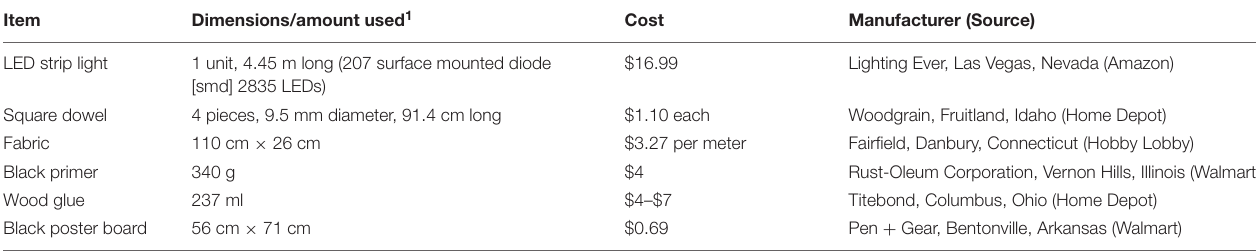
TABLE 2 | Materials for the construction of the imaging